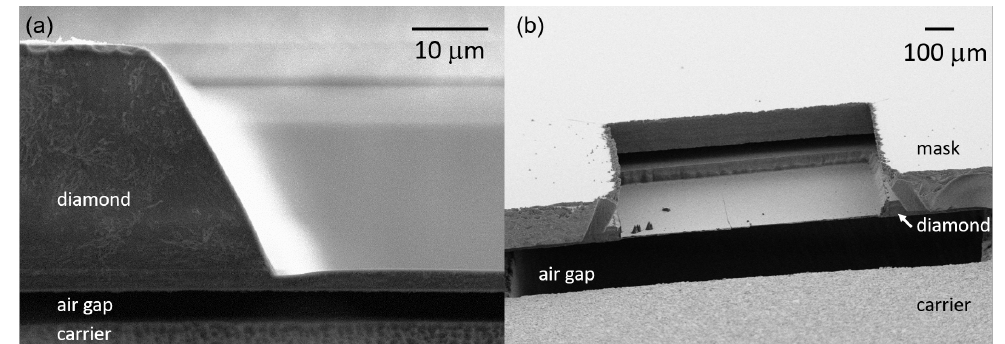
Figure 2. Electron microscopy characterization of the etched membranes: ( a ) Cross-sectional view of a membrane etched using our SF 6 -based recipe. The membrane’s thickness at its edge as deduced from this image is 2.8 µ m. A trench with a depth of 0.8 µ m is visible in the image; ( b ) View of a membrane etched using the Cl 2 -based process (taken under ≈ 80 ◦ ). For the membrane etched in the Cl 2 -based process, the mask is still attached. In case of the Cl 2 -based process, a needle wall had to be removed mechanically from the outer edge of the membrane. This process occasionally leads to cracks in the membrane. In contrast the outer edge of the membrane etched in the SF 6 -based process is smooth without further treatment.